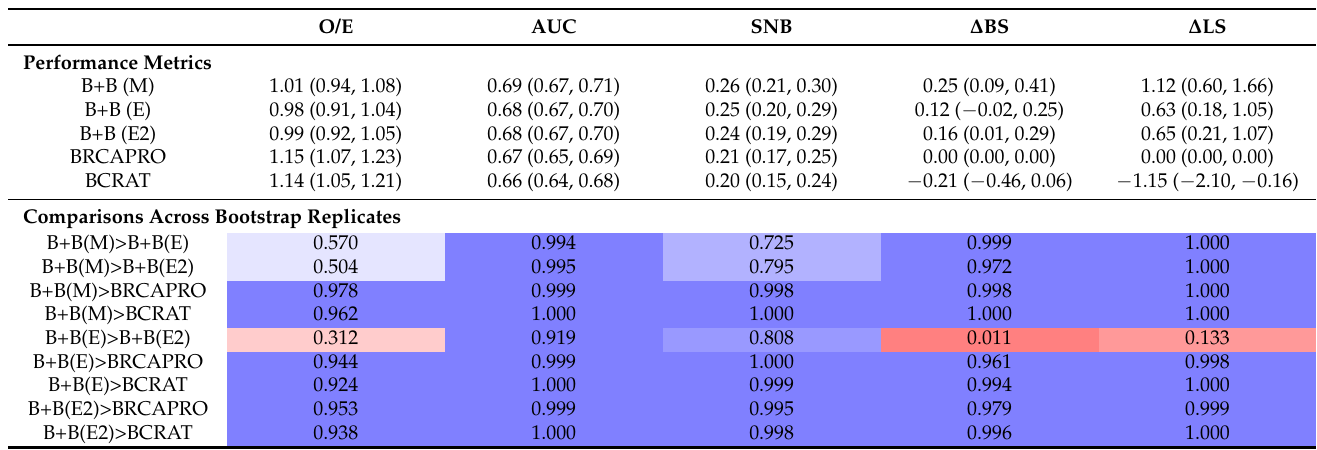
Table 2. Five-year performance on a simulated dataset with 45,557 probands (717 cases). B+B: BRCAPRO + BCRAT. ∆ BS: % relative improvement in Brier Score compared to BRCAPRO. ∆ LS: % relative improvement in logarithmic score compared to BRCAPRO. The “Comparisons Across Bootstrap Replicates” section shows pairwise comparisons involving the combination models across 1000 bootstrap replicates of the validation dataset; the row for A > B shows the proportion